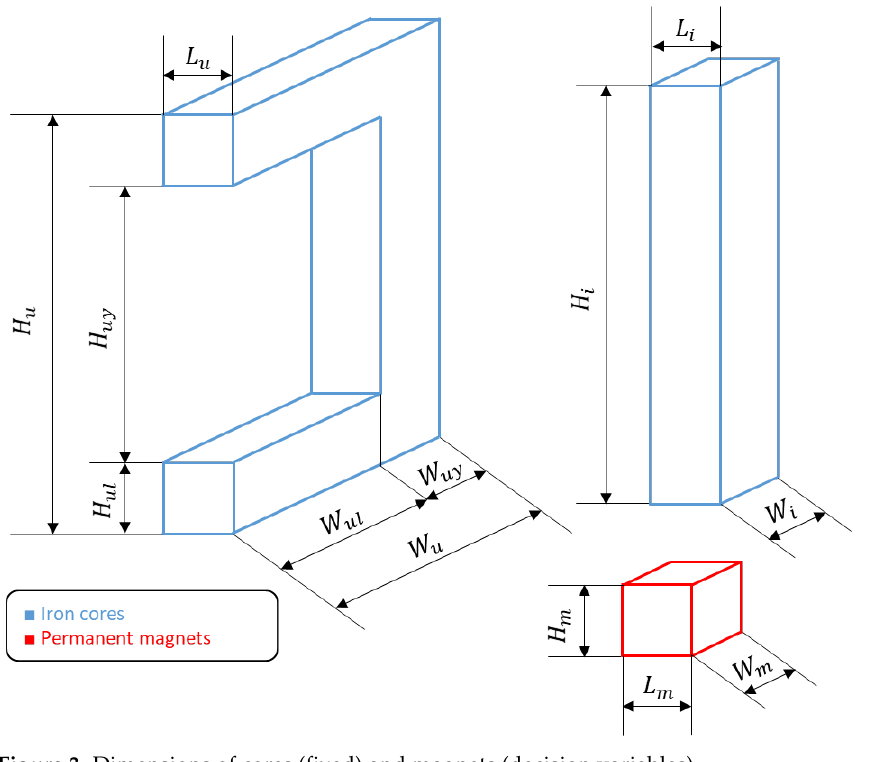
Figure 3. Dimensions of cores (fixed) and magnets (decision variables).